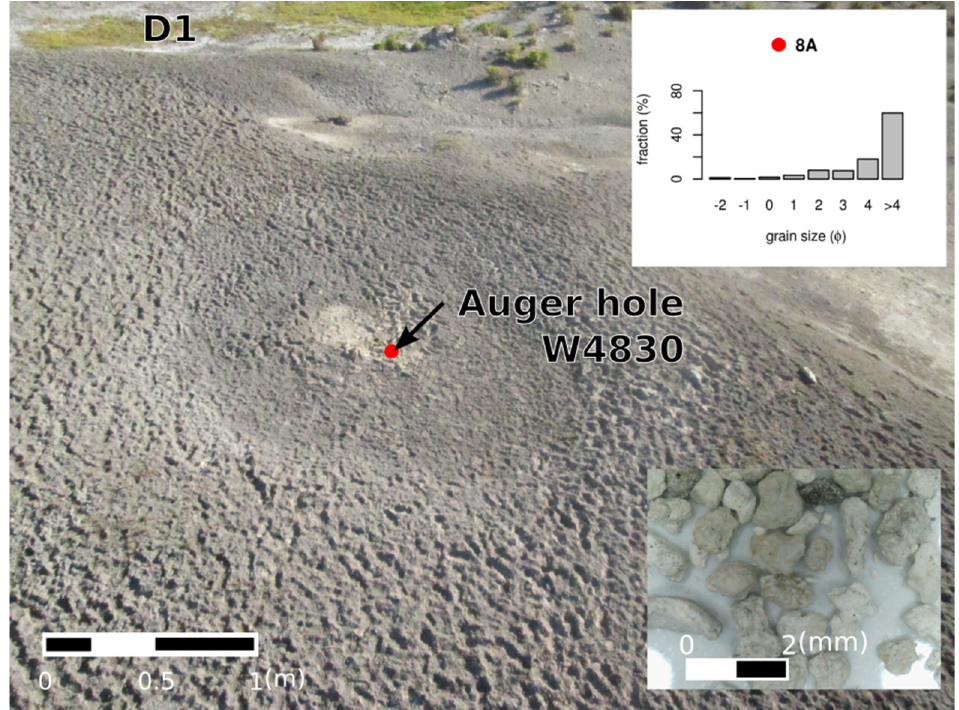
Figure 16. Location of TL sample W4830. The photo is looking north toward feature D1, on fine-grain sediment blanketing the sinter aprons surrounding the depressions. Photo taken in June, 2014 under dry conditions. Sediment in the auger hole is uniform, primarily (65%) silt and clay with clasts of subangular to rounded sinter up to 6 mm. The auger hole met refusal at 100 cm. The grain size chart 8A for sediment collected immediately above the TL sample depth of 47 cm.